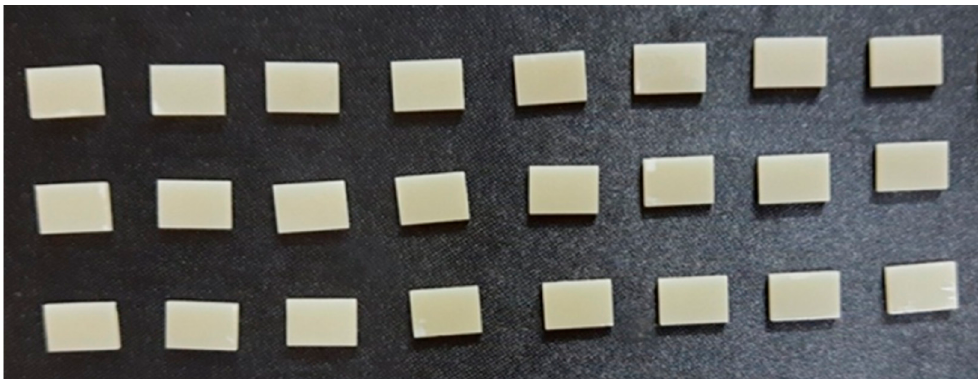
Figure 4. Specimens prepared by milling .